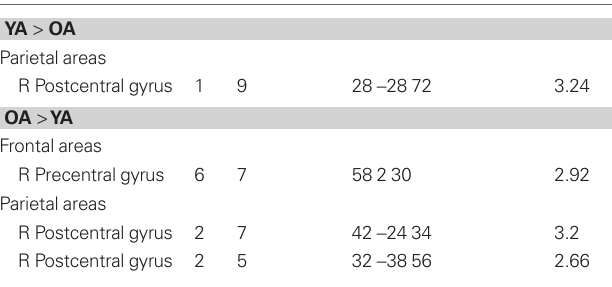
Table 4 | Young adults (YA) versus older adults (OA) R sensorimotor cortex fcMRI (uncorrected p = 0.01, right sensorimotor cortex ROI analyses).